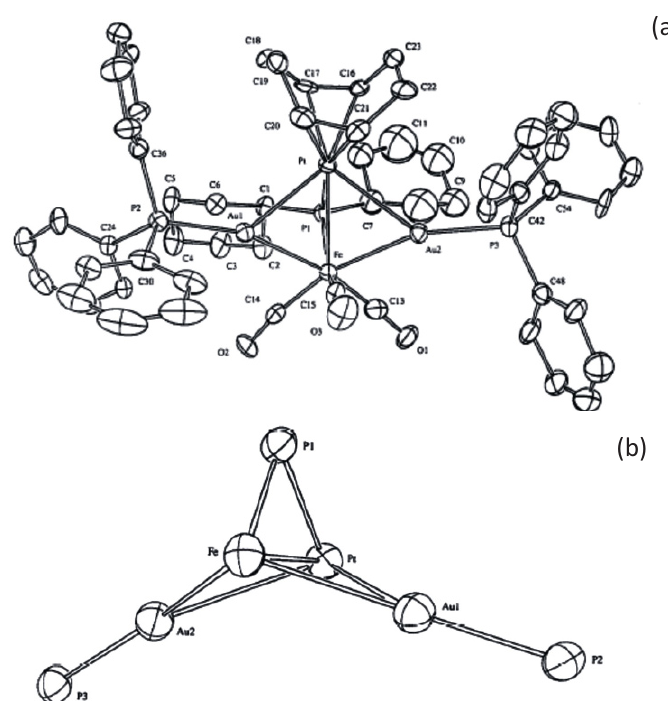
Figure 14. Structure of η 4 -cod)Pt{µ-Au(PPh